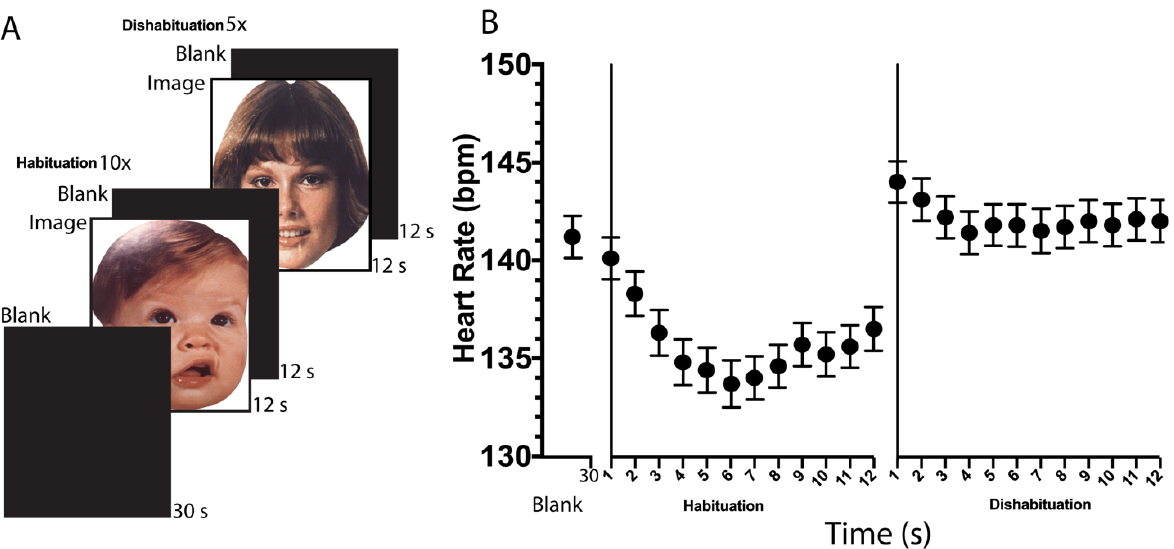
Figure 1. The cardiac-oriented response is triggered by stimulus display. ( A ) The visual stimulus category was composed of the presentation of a blank screen followed by the picture of a baby or woman ’ s face and then a blank. In this pictorial example of the habituation session, a baby face picture was presented ten times. Then, during the dishabituation session, the other face picture was used; in this example, a woman ’ s face followed by a blank was presented five times. Repetitions and duration that each visual stimulus displayed are depicted at the top-left and bottom-right corners of the pictures, respectively. ( B ) Previous unpublished data representing a canonical averaged heartbeats deceleration during the first three images presented for the habituation (baby face picture) and dishabituation (woman face) visual stimuli. Data were collected with a commercial setup, different from that described here. Dots and bars represent mean and standard error, respectively, calculated from 162 subjects with no prenatal alcohol exposure.